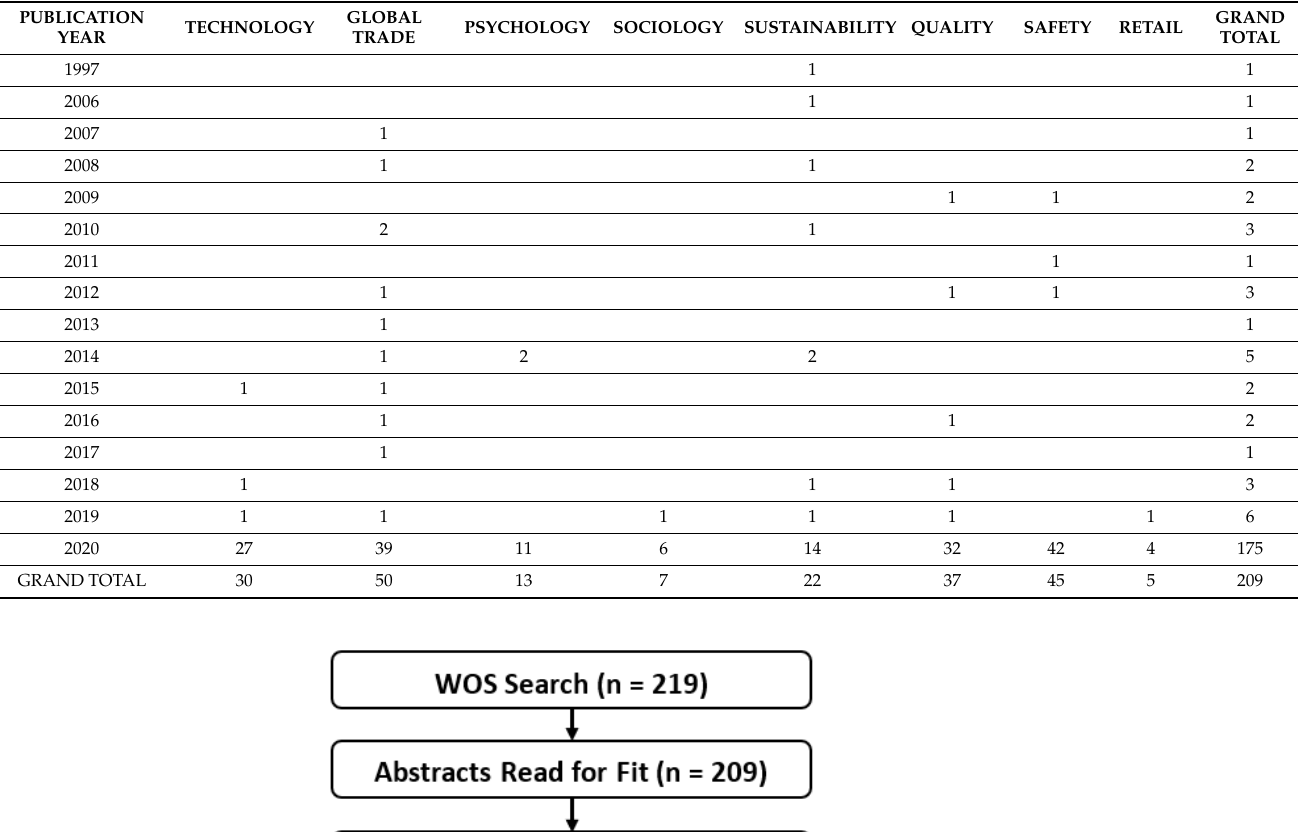
Table 9. Research Articles by Subject.